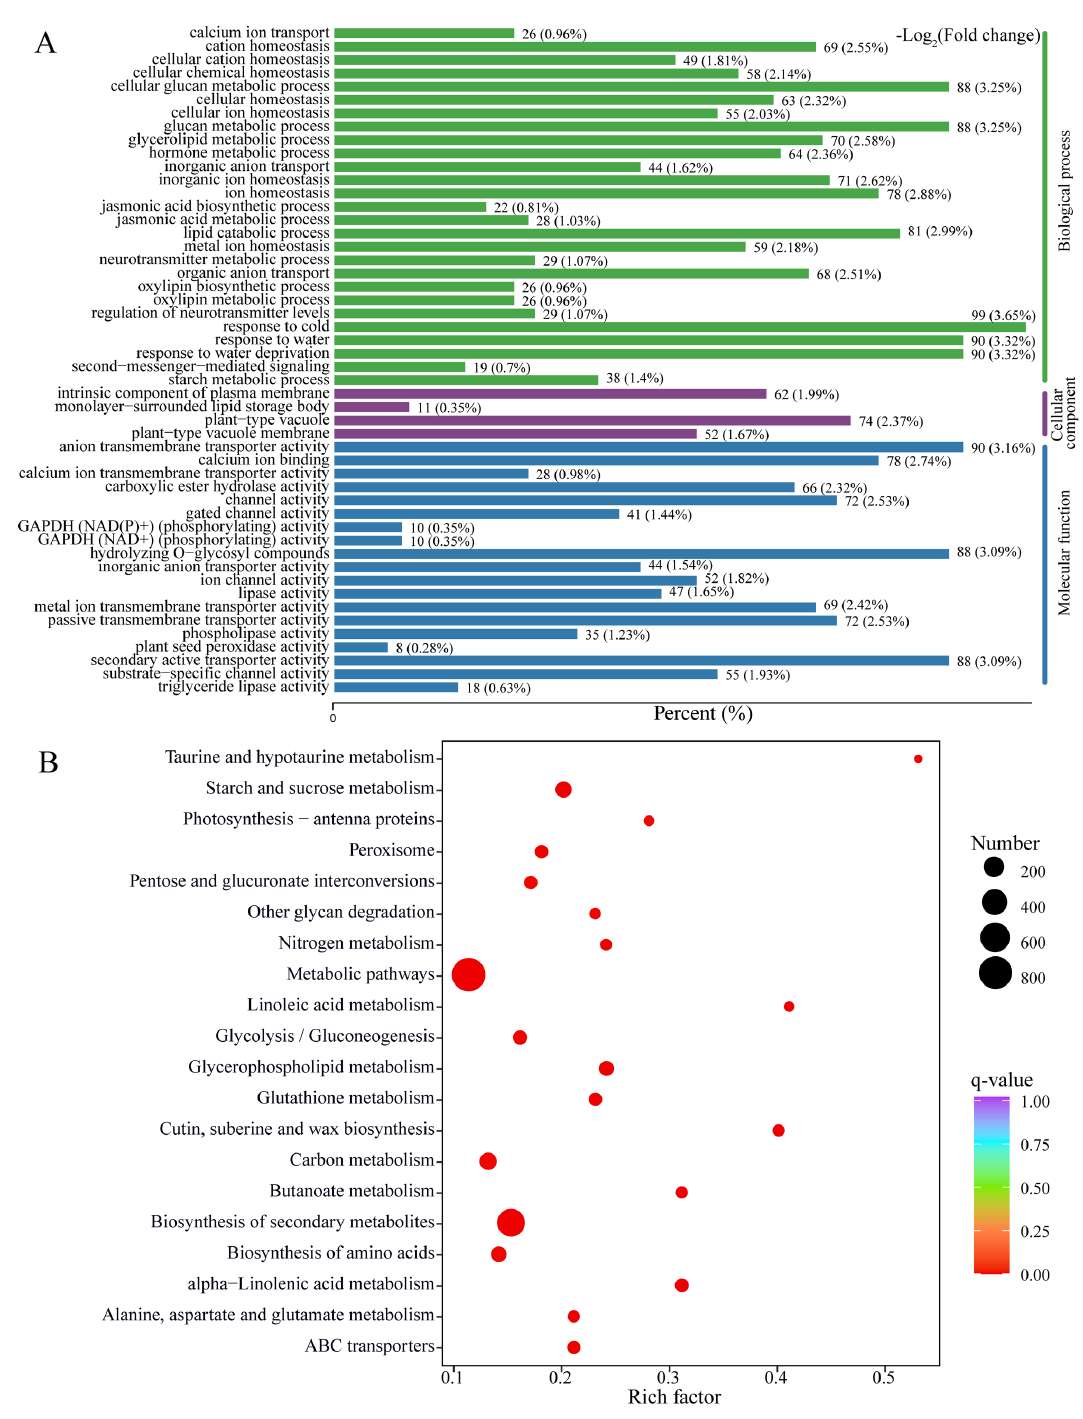
Figure 4. Functional annotation of differentially expressed genes. ( A ) GO enrichment analysis of differentially expressed genes (DEGs). ( B ) KEGG pathway enrichment of DEGs. Gene ratio is calculated as the ratio of DEGs to all annotated genes.